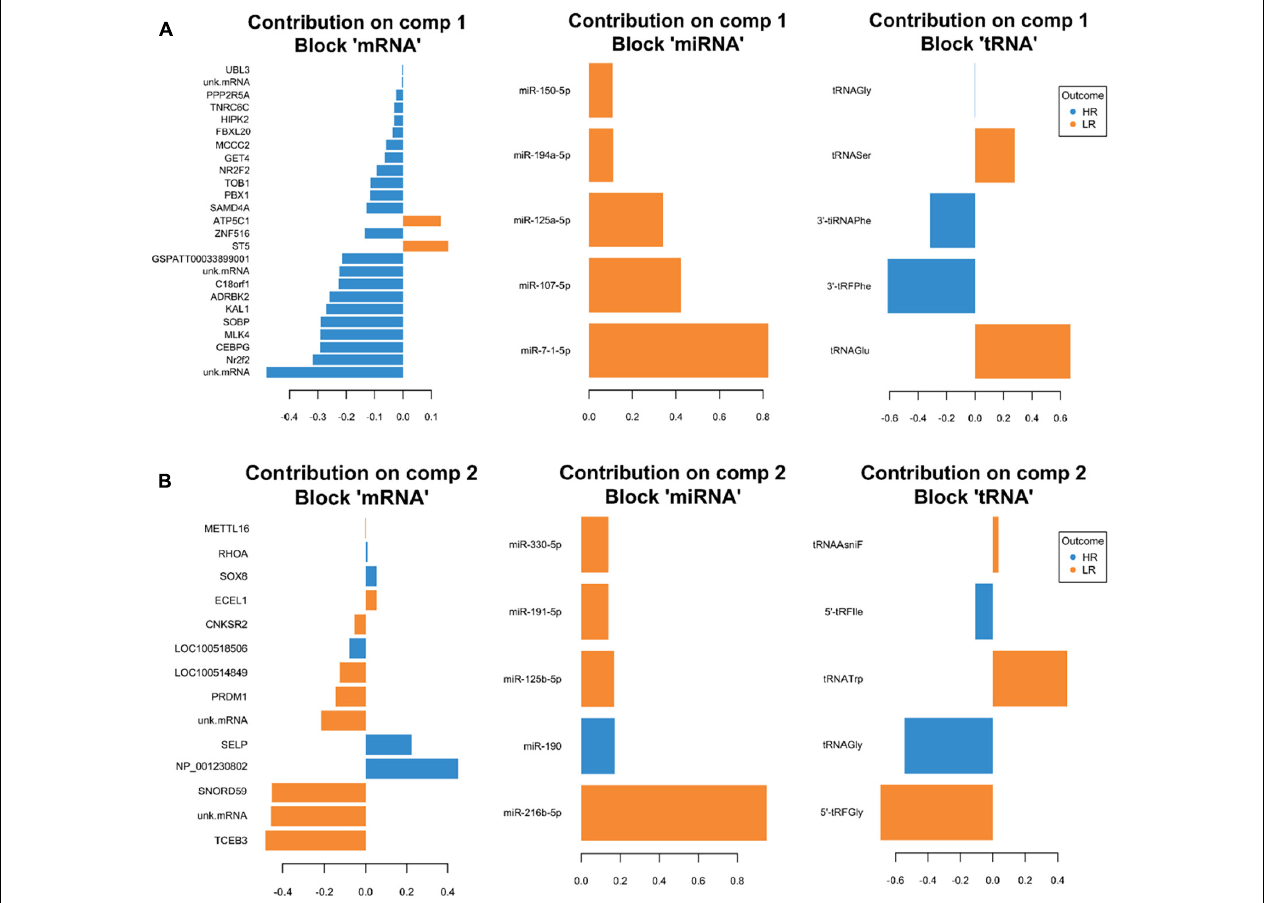
FIGURE 4 | Representation of the optimal biomarker panel of mRNA, miRNA, and tRNA correlated to coping behavior haplotype groups over two component sets in the hippocampus. DIABLO minimal set of feature selection across data types could discriminate between high-reactive (HR) and low-reactive (LR) groups in component 1 (A) and component 2 (B) . Blue-colored bars are indicators for the HR group, yellow-colored bars indicate the LR group (DIABLO: Data Integration Analysis for Biomarker discovery using Latent